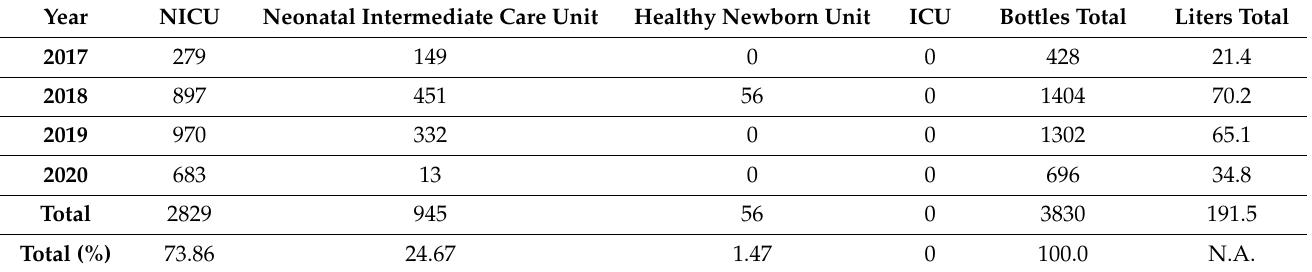
Table 4. PBM in 50 mL distribution bottles delivered from the Human Milk Bank to Pediatric departments.